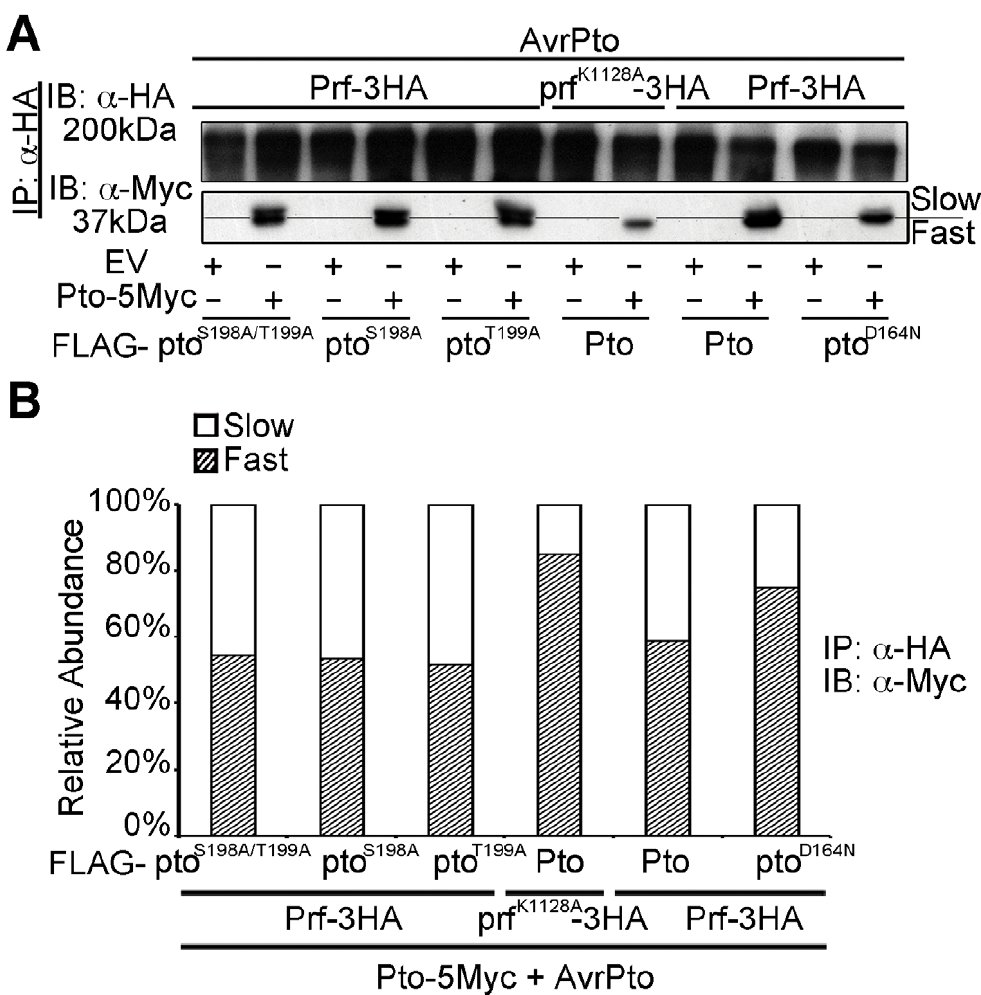
Figure 3. Transphosphorylation is required for Ser-198 and Thr-199 phosphorylation. ( A ) In trans inhibition of Pto S198 and T199 phosphorylation. The slower migrating from of Pto is suppressed in trans by prf K1128A and pto D164N , but not pto S189A/T199A , pto S189A and pto T199A . Pto- 5Myc, Pto-FLAG, pto mutant-FLAG, AvrPto, Prf-3HA, prf K1128A -3HA constructs were transiently expressed in wild-type N. benthamiana as indicated, Prf-3HA and prf K1128A -3HA were immunoprecipitated (IP) using anti-HA antibodies. Immunoblots (IB) were performed with the antibodies indicated on the left. ( B ) The slower migrating from of Pto was suppressed in trans by prf K1128A and pto D164N , but not by pto S189A pto T199A and pto S189A/T199A . Pto-5Myc, Pto-FLAG, pto mutant-FLAG, AvrPto, Prf-3HA, prf K1128A -3HA constructs were transiently expressed in wild-type N. benthamiana as indicated. Prf-3HA and prf K1128A -3HA were immunoprecipitated using anti-HA antibodies. The relative abundance of slow- and fast-migrating forms of Pto-5Myc after AvrPto recognition was quantified two days post infiltration, from anti-Myc immunoblots using Quantity One, Bio-Rad (adjusted volume=[CNT*mm2] data counts/mm 2 ).